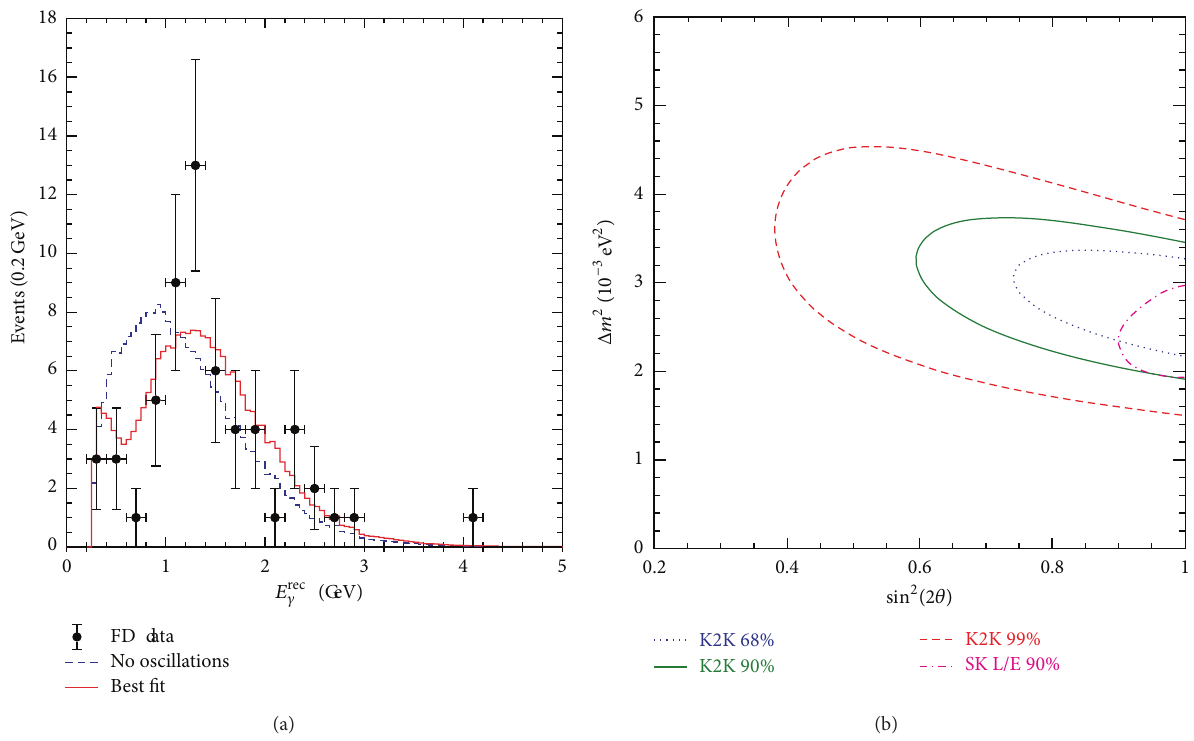
Figure 10: (a) Reconstructed energy spectrum for 58 one-ring events detected by K2K. The dashed blue line is for MC no oscillations; solid red line is the MC oscillation best fit. Both MC histograms are normalized to the data. (b) Comparison of K2K results with the SK atmospheric neutrino measurement [102, 103].